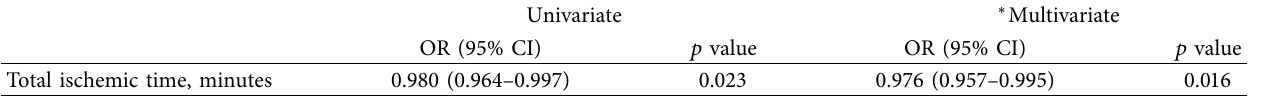
Table 4: Predictor of a decrease in the WMSI value among patients with TITs of 180 minutes or less.